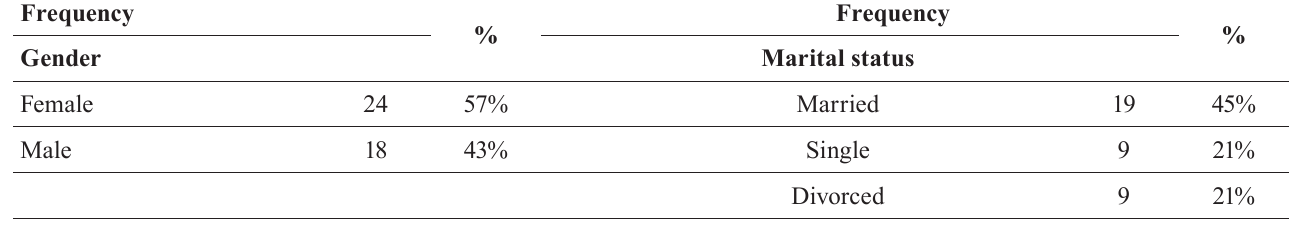
TABLE I – P rofile of participants with AS treated at the Pharmacy of the 9 th Regional Health of the State of Paraná